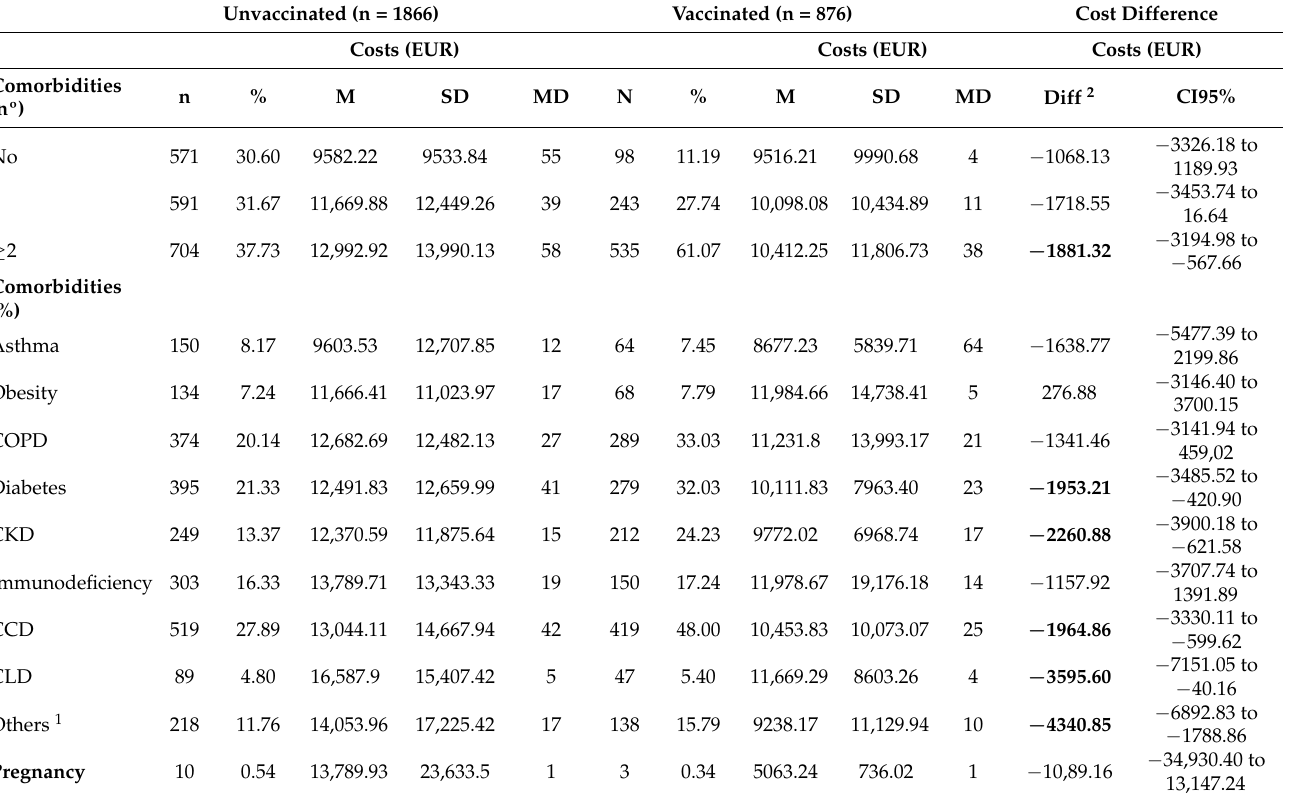
Table 4. Medical conditions and mean costs of hospitalized influenza cases by vaccination status. Unvaccinated (n = 1866) Vaccinated (n = 876) Cost Difference Costs (EUR) Costs (EUR) Costs